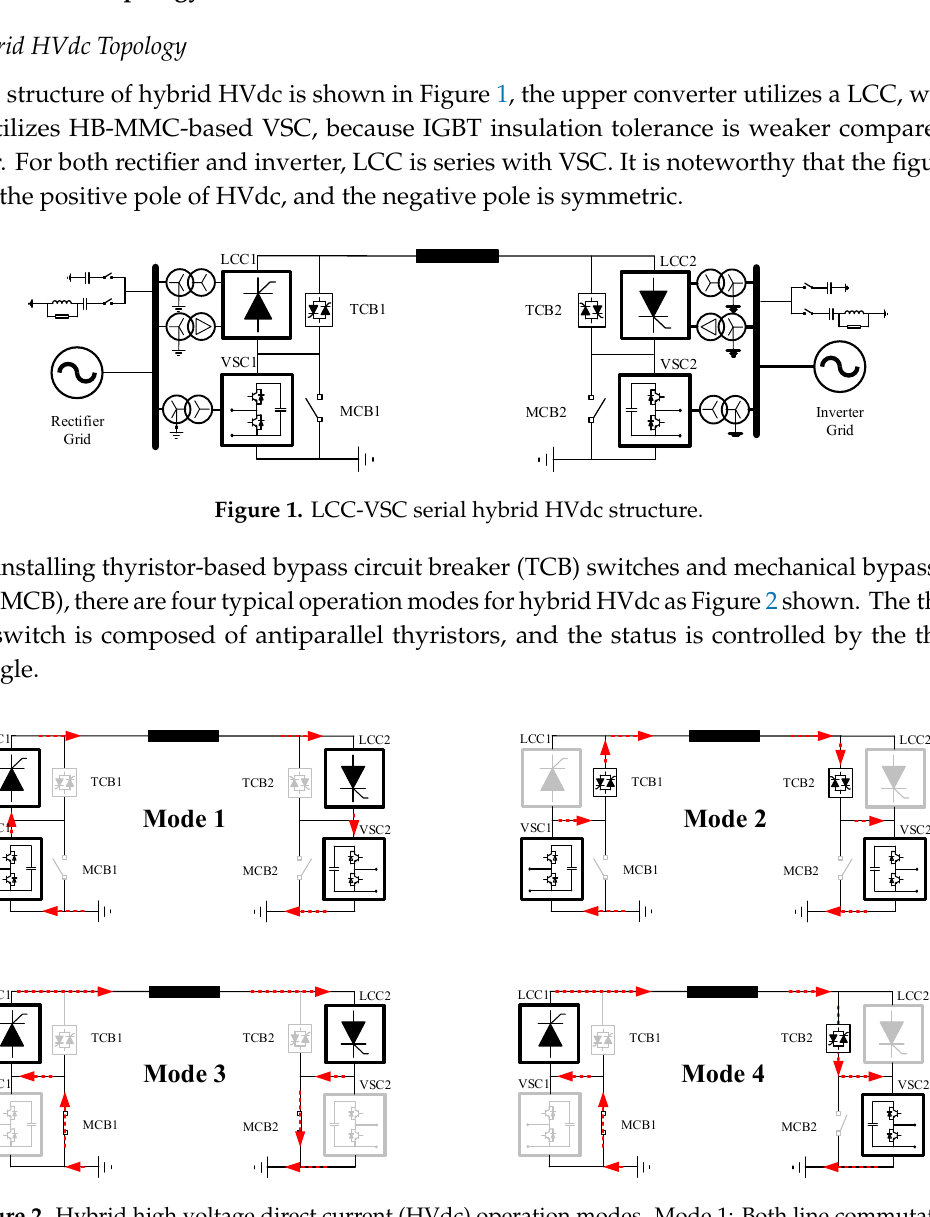
Figure 2. Hybrid high voltage direct current (HVdc) operation modes. Mode 1: Both line commutated converters (LCCs) and voltage source converters (VSCs) are working; mode 2: Only VSCs are working; mode 3: Only LCCs are working; Mode 4: LCC is working on one side, and VSC is working on the other side.